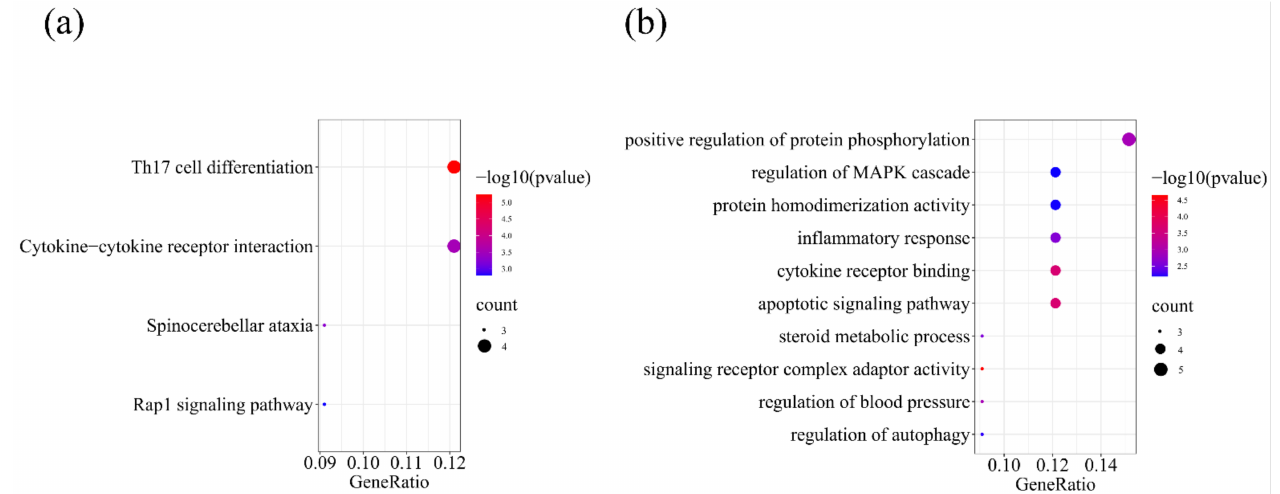
Figure 2. KEGG and GO enrichment analysis of 33 overlapped genes by Metascape. ( a ) Bubble chart for KEGG enrichment analysis. ( b ) Bubble chart for GO enrichment